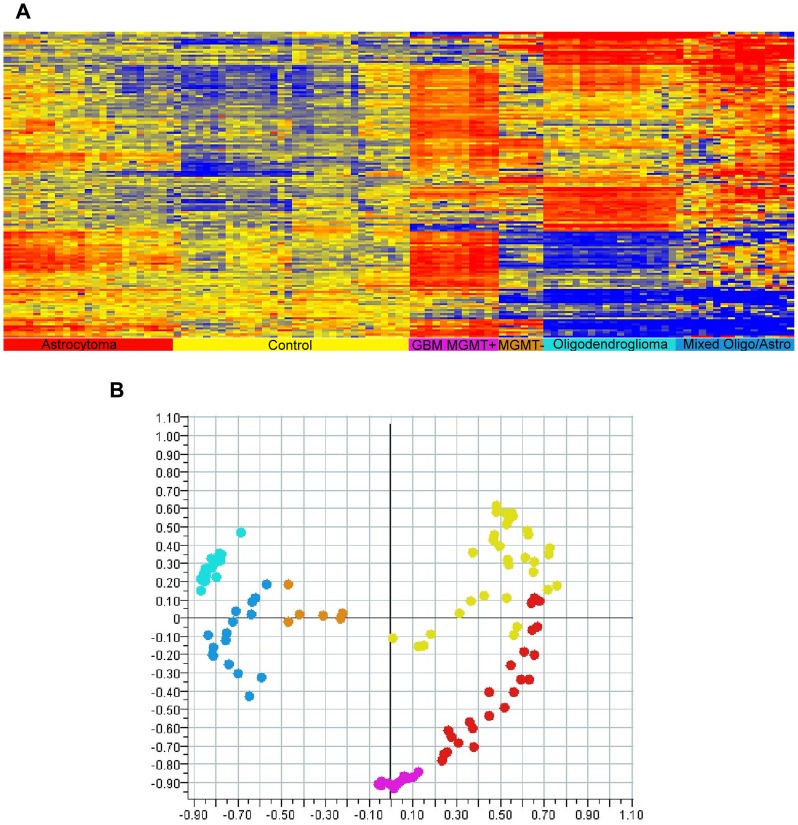
Classification of multiple cancer types and molecular markers.Top: six different classes of brain tumor patients were tested for their immunosignature. We examined Glioblastoma multiformae (MGMT- is brown, MGMT+ is purple), astrocytoma grade II (red), oligodendroglioma (cyan) and mixed oligo/astro (blue) against otherwise healthy controls (yellow). We used a 1-way ANOVA to select the 100 most significant peptides, p<10−18. High (red) and low (blue) signals correspond to patient antibodies detected with a fluorescently labeled anti-human secondary. Data was grouped using hierarchical clustering on both peptides (Y-axis) and patients (X-axis). Bottom right: principal components display of the separation between samples. X and Y axes represent the first two principal components making up 64% of the total variance across the samples. Patient information is found in Table 1.